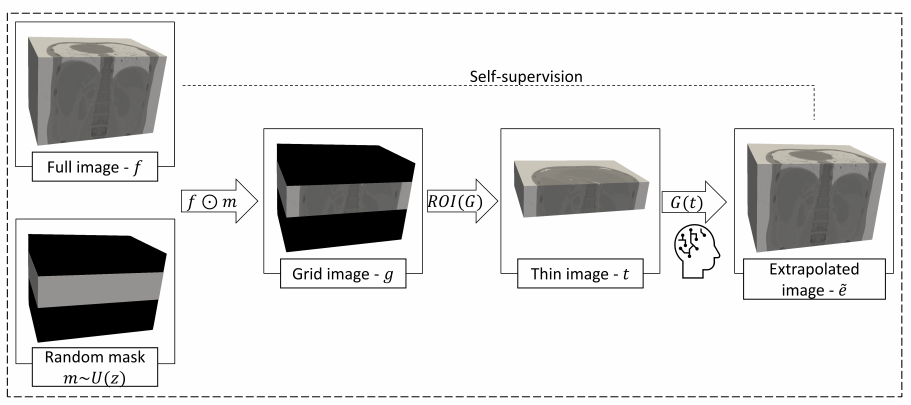
Figure 2. Schematic overview of the workflow. The data are stochastically processed at training time to create a self-supervised learning